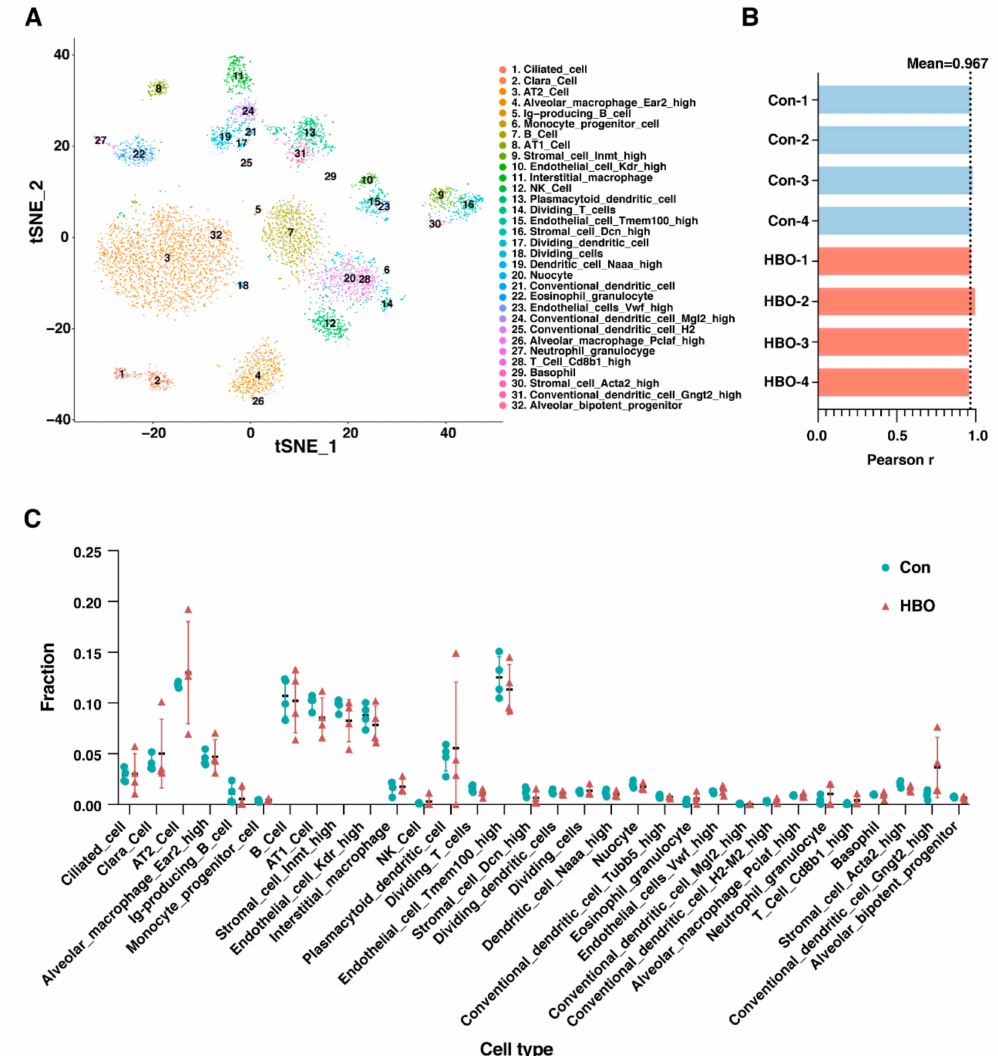
Figure 3. Repetitive HBO exposure had little e ff ect on the composition of the 32 cell subtypes of lung tissue through CIBERSORTx analysis. ( A ) t-distributed stochastic neighborhood embedding (t-SNE) projection plot of the adult mouse lung scRNA-seq data from the MCA project [29]. Di ff erent colors indicate di ff erent clusters, key in figure indicates which colour corresponds to which cell type. 32 clusters identified. ( B ) Bar plot shows Pearson correlation coe ffi cients, for control (blue) and HBO-treated (red) mice, between our transcriptome data and the scRNA-seq data. Black dotted line indicated mean Pearson correlation coe ffi cients across all samples. ( C ) Comparisons of the ratios of the 32 cell types in control (blue) and HBO-treated (red) groups. Y -axis indicates the fraction of each cell type, X -axis are the 32 cell types. Error bars represent standard